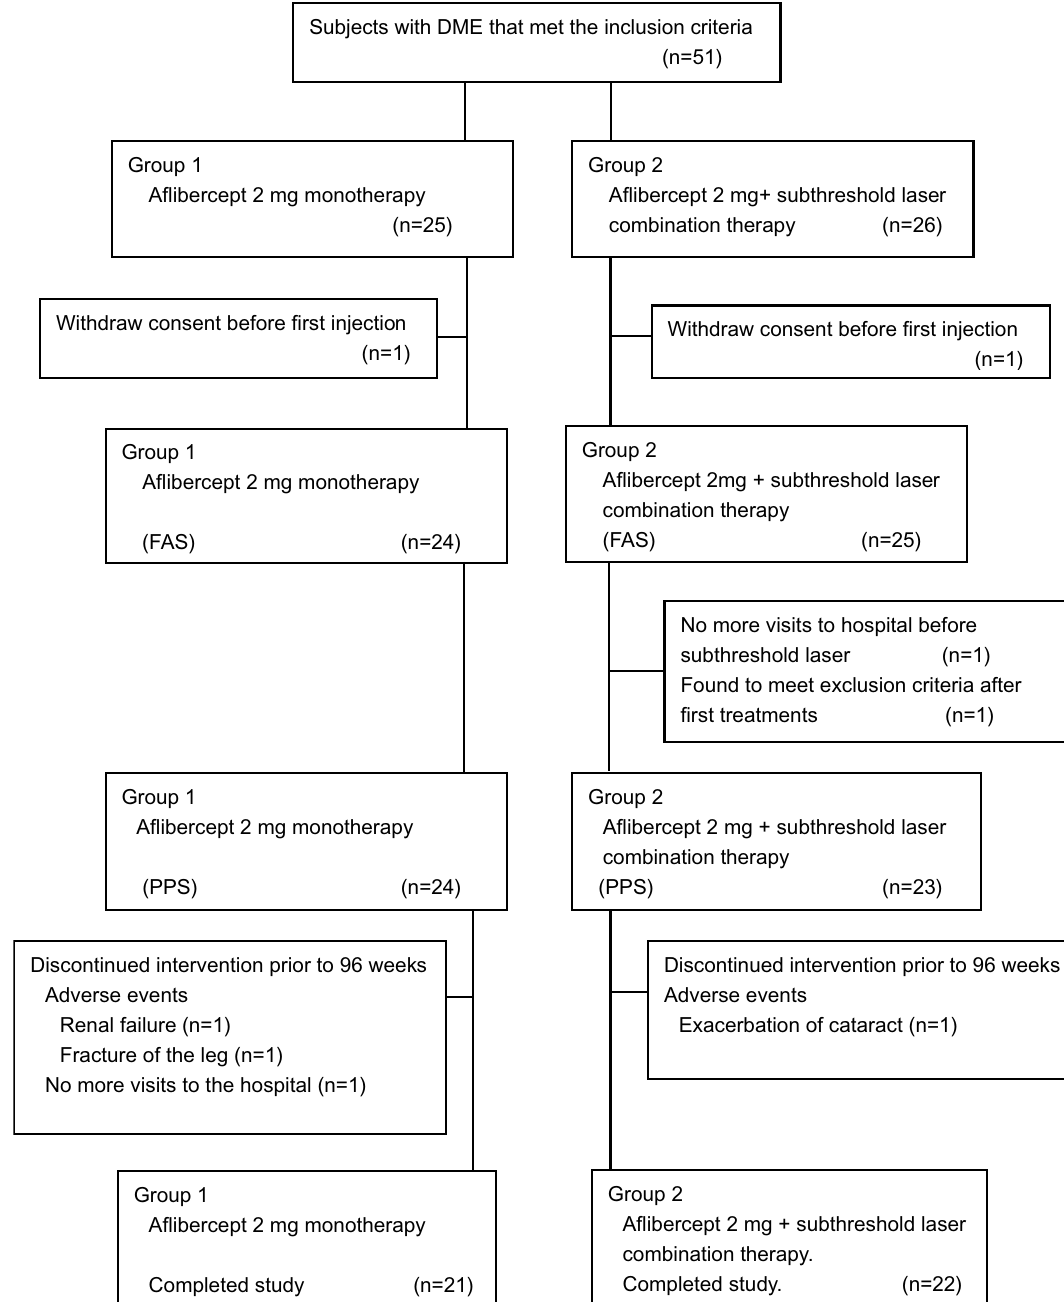
Figure 1. Flow diagram for selection of patients. DME diabetic macular edema; FAS full analysis set; PPS per protocol